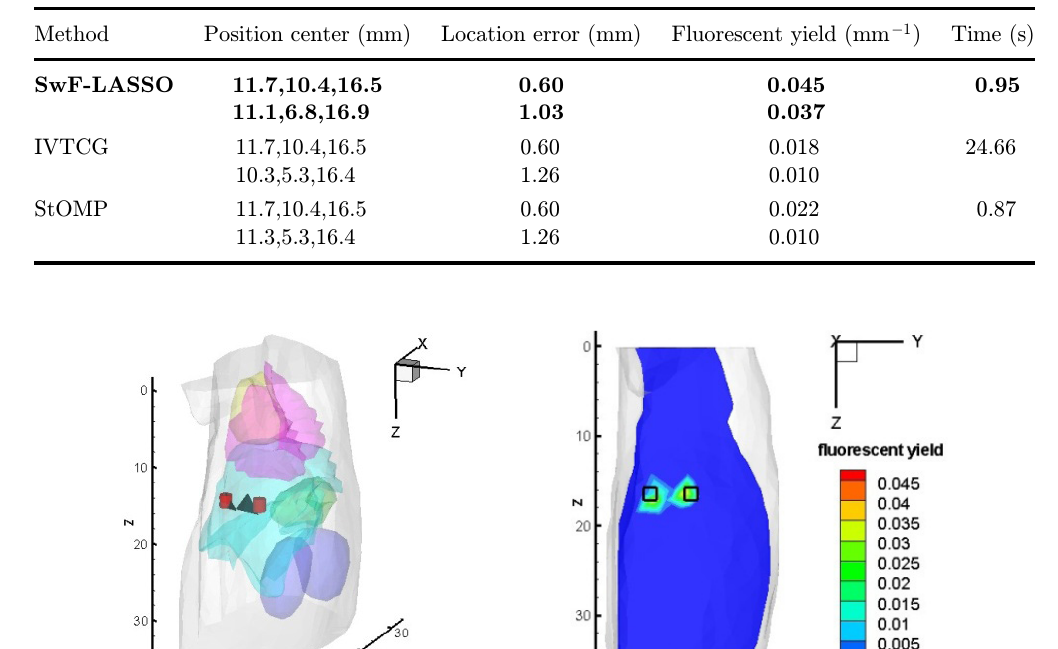
Table 3. Results for double targets reconstruction.